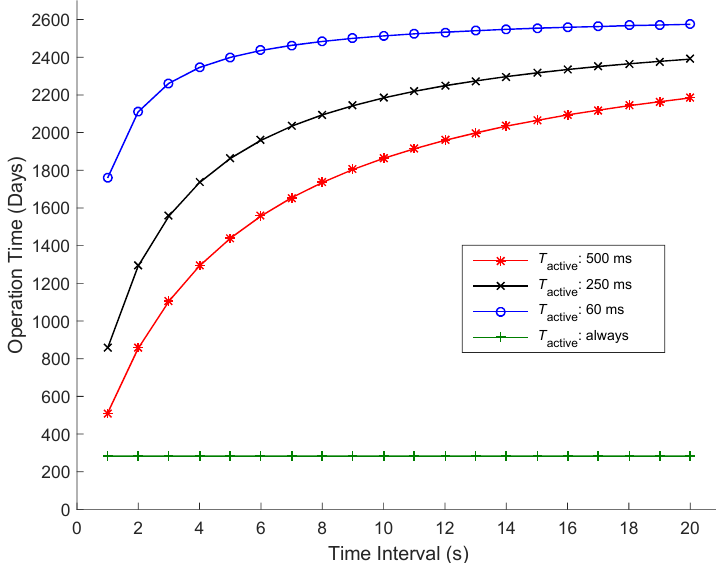
Figure 10. Calculation of the wake-up receiver’s operation time in different active